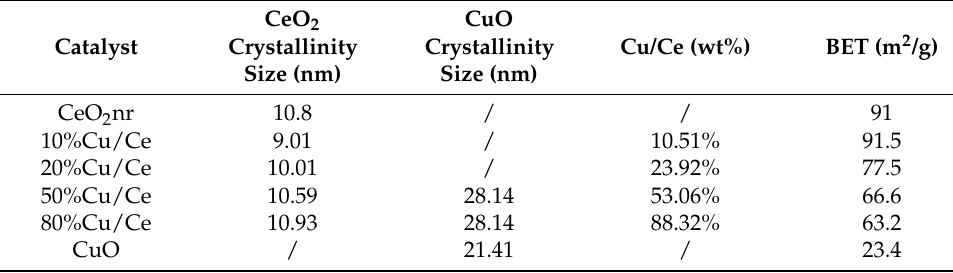
Figure 3. TEM images of the CuO/CeO 2 catalysts: ( a ) CeO 2 nr, ( b ) 10%Cu/Ce, ( c ) 20%Cu/Ce, ( d ) 50%Cu/Ce, ( e ) 80%Cu/Ce, and ( f ) CuO.